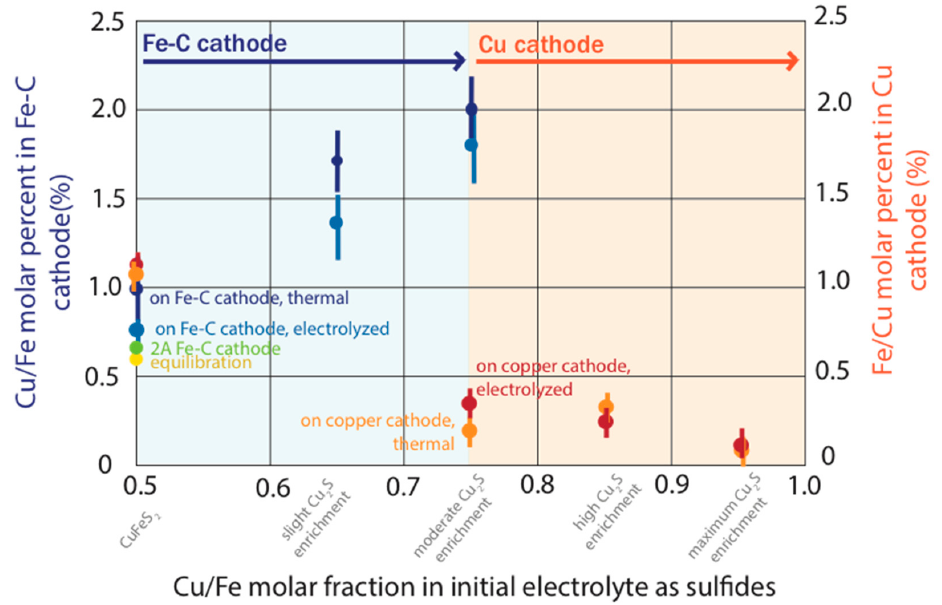
Figure 6. Measured composition of the metal cathodes after electrolysis and thermal treatments as the initial copper sulfide enrichment in the electrolyte increases. The iron extraction regime is on the left-hand side, with mol% Cu in cast iron on the vertical axis. The copper extraction regime is on the right-hand side, with mol% Fe in copper on the vertical axis. Compositions are measured by EDS and obtained from at least 5 readings: the average is plotted with the standard deviation range.